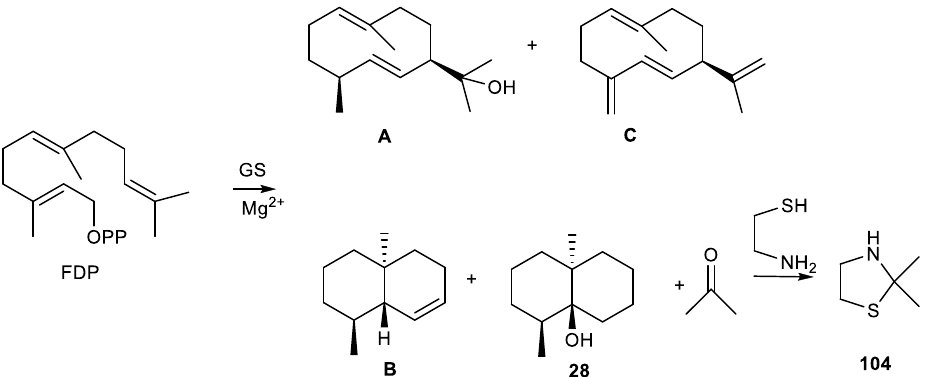
( 104 ) (Figure 14) [298]. mation of 2,2-dimethylthiazolidine